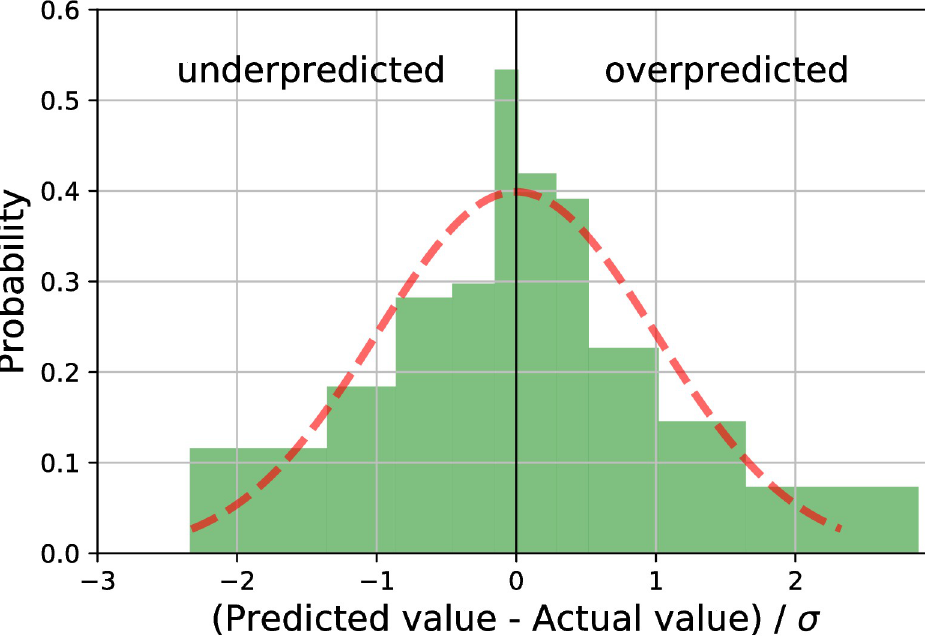
Fig 4. Histogram of errors for predictions using our neural network. The dotted red line is fitted with a normal distribution. Each bin contains four data points. Overpredicted refers to predicted values are better than post-treatment cartilage repair scores. Underpredicted refers to predicted values are worse than post-treatment cartilage repair scores.